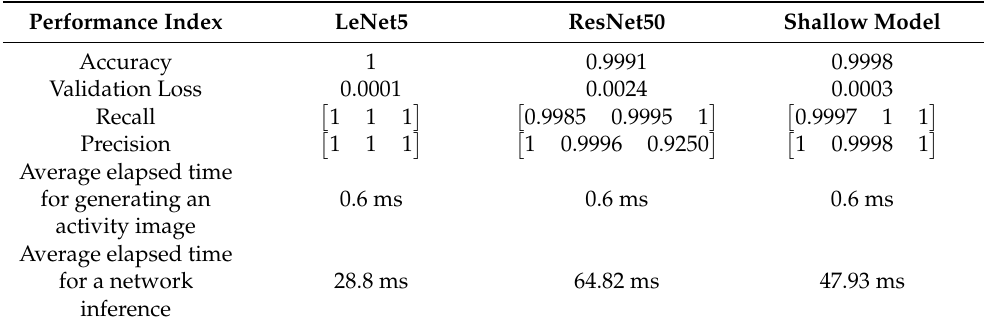
Table 6. Evaluation of performance indices for the considered recognition models when using the AVM data bundle of the green hen test